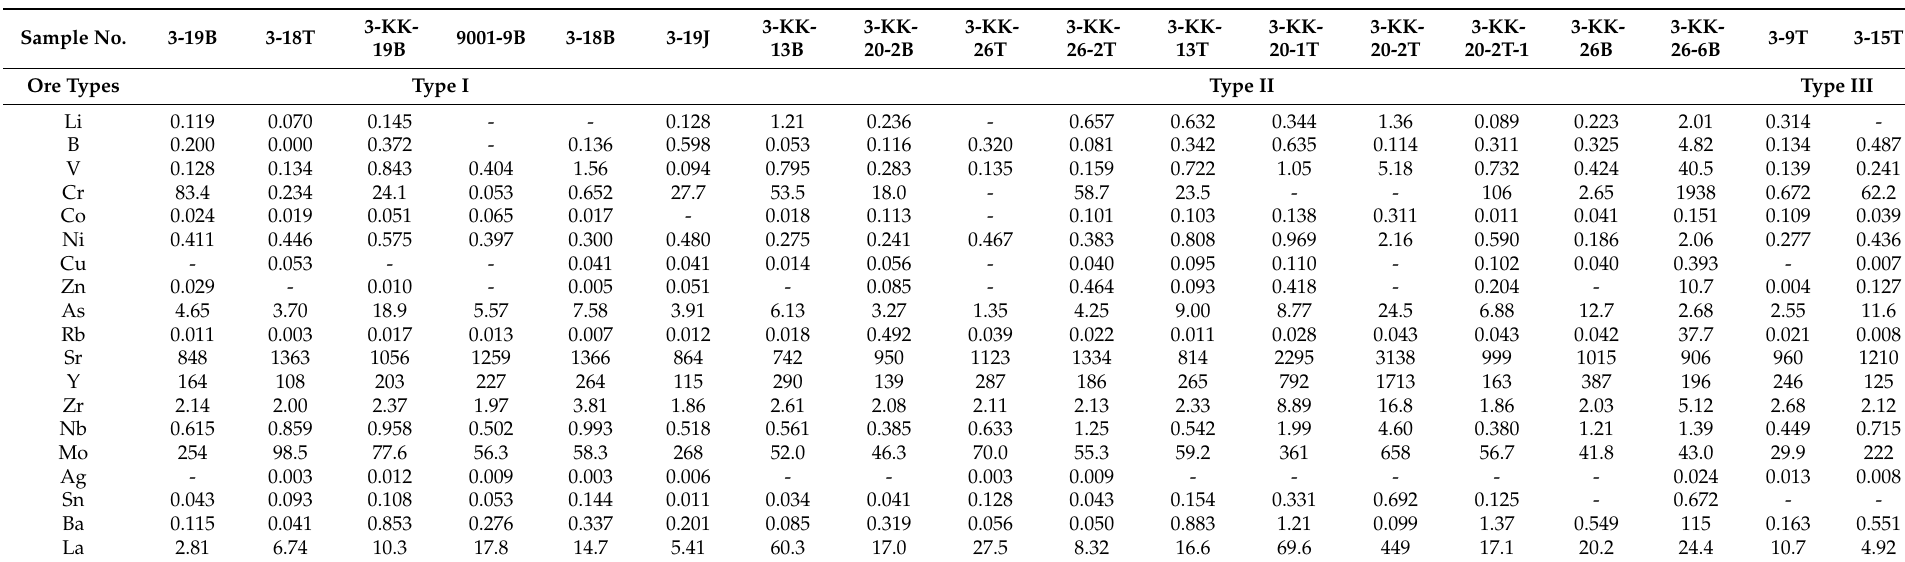
Table 2. Representative trace element compositions of scheelites from the Doranasai gold deposit